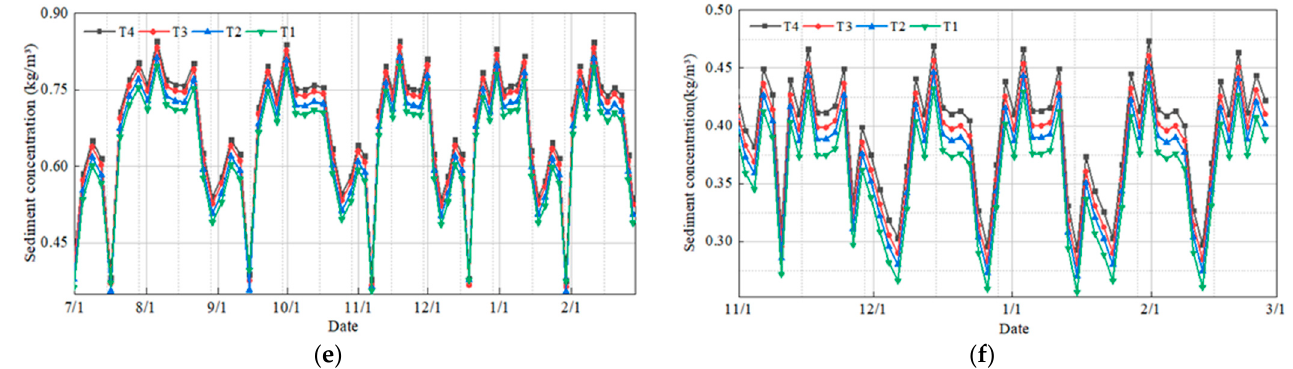
Figure 12. Variation of sediment concentration at characteristic points in flood season and non-flood season in different schemes, ( a ) is scheme I flood season, ( b ) is scheme I non-flood season, ( c ) is scheme II flood season, ( d ) is scheme II non-flood season, ( e ) is scheme III flood season, ( f ) is scheme III non-flood season.